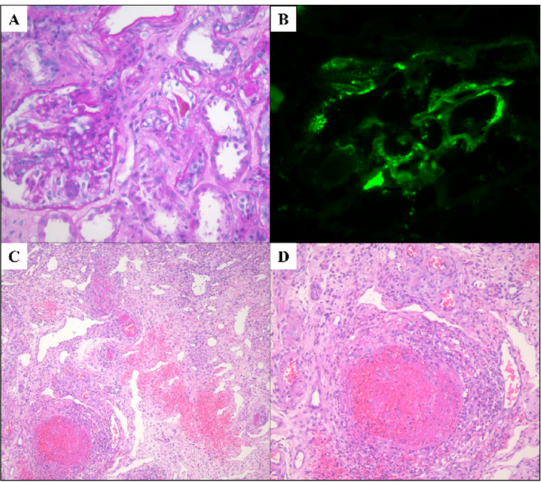
Figure 1. Histologic features of kidney and ileum in a patient with IgA vasculitis after COVID-19 vaccination. ( A ) Glomerulus showing mesangial hypercellularity and mesangial matrix expansion (PAS stain, original magnification: × 400). ( B ) Immunofluorescent staining reveals IgA deposits in mesangium (original magnification: × 400). ( C ) Diffuse inflammatory infiltration in submucosal layer of ileum, and fibrinoid necrotizing vasculitis in several vessels (H&E stain, original magnification: × 100). ( D ) Fibrinoid necrotizing vasculitis of ileum (H&E stain, original magnification: ×